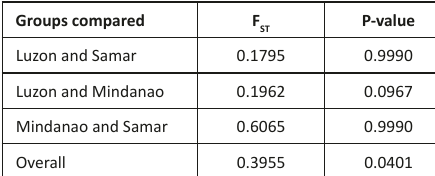
between subpopulations of Philippine